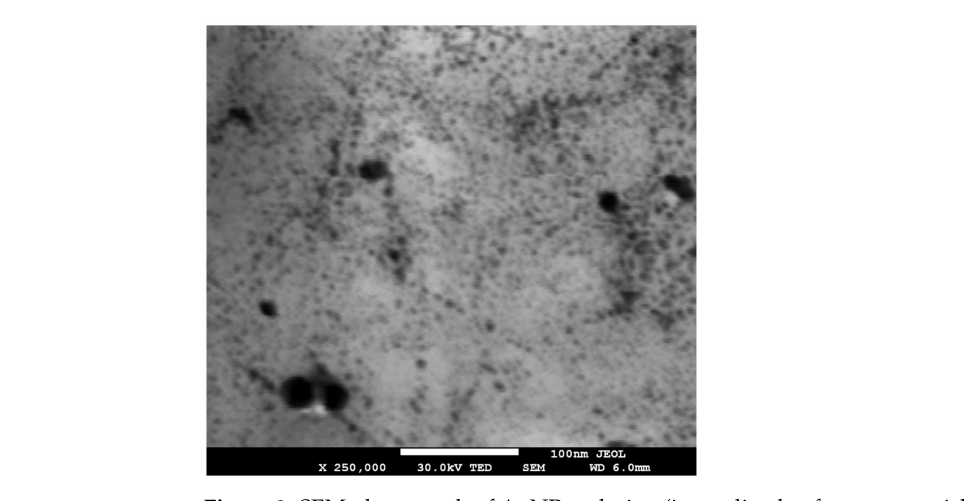
Figure 2. SEM photograph of AgNPs solution (immediately after nanoparticle synthesis).